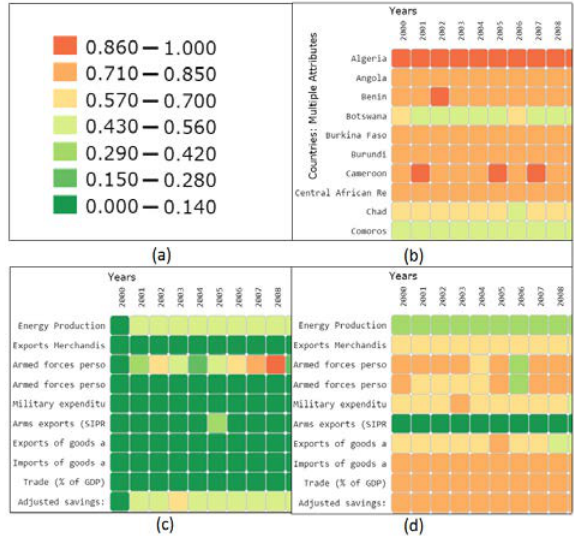
Figure 13. The software architecture for